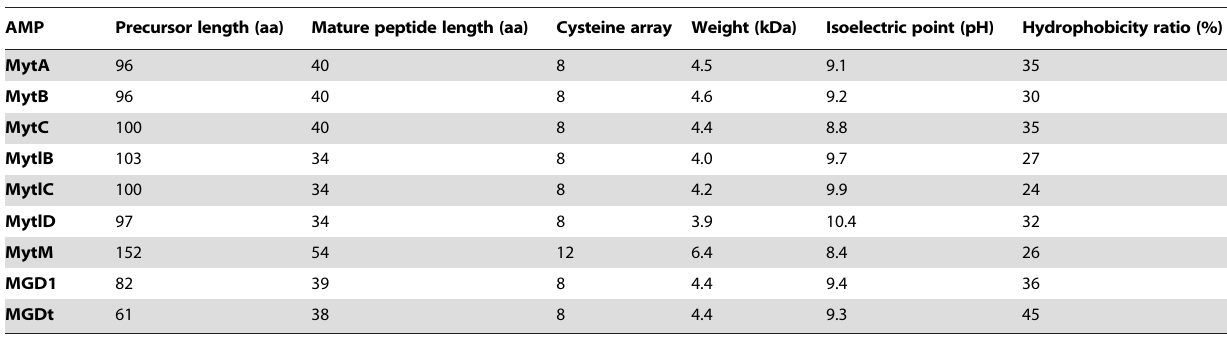
Table 1. Features of the selected mussel AMPs.